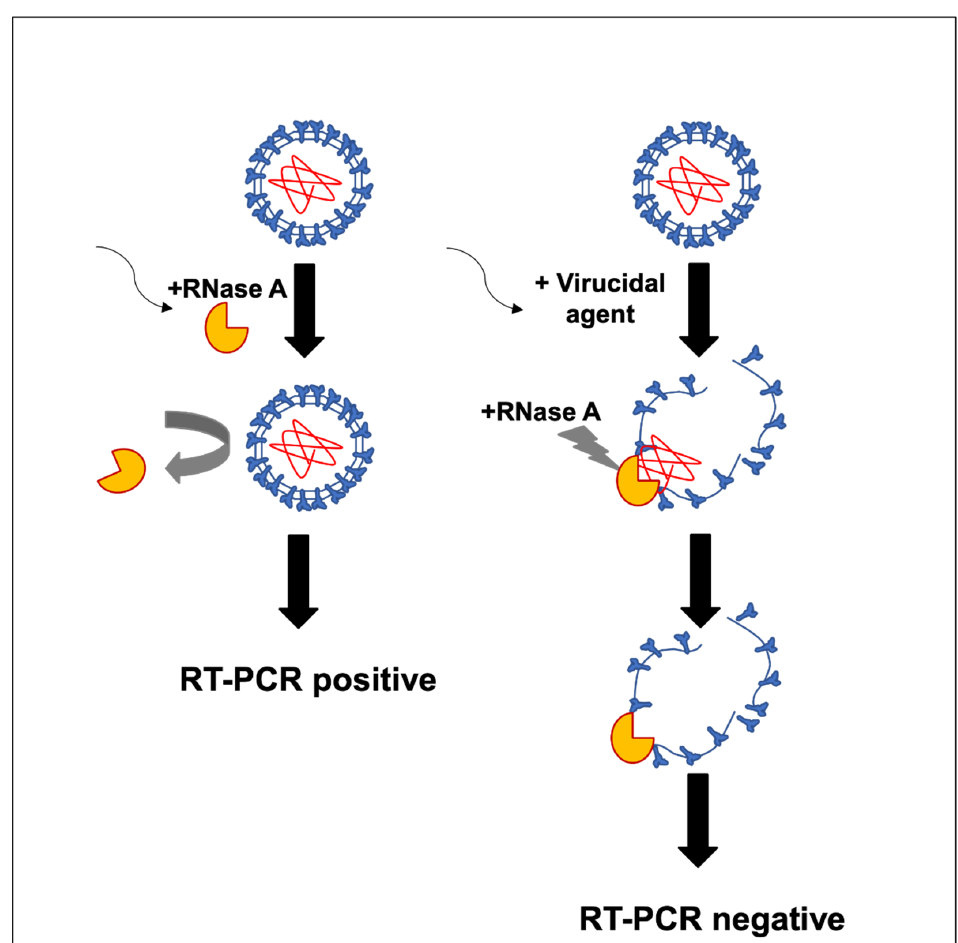
Figure 1. Model of the mechanism of action by mouthwash products on the viral envelope. Previously diagnosed positive samples of SARS-CoV-2 RNA by RT-PCR were incu- bated in the presence of RNase to test whether enveloped viral particles, presumably in- fective, would protect the RNA from the enzymatic degradation. Figure 2 shows the sta- bility of the viral RNA after the RNase treatment, suggesting the viral envelope protects the viral genome from enzymatic digestion.